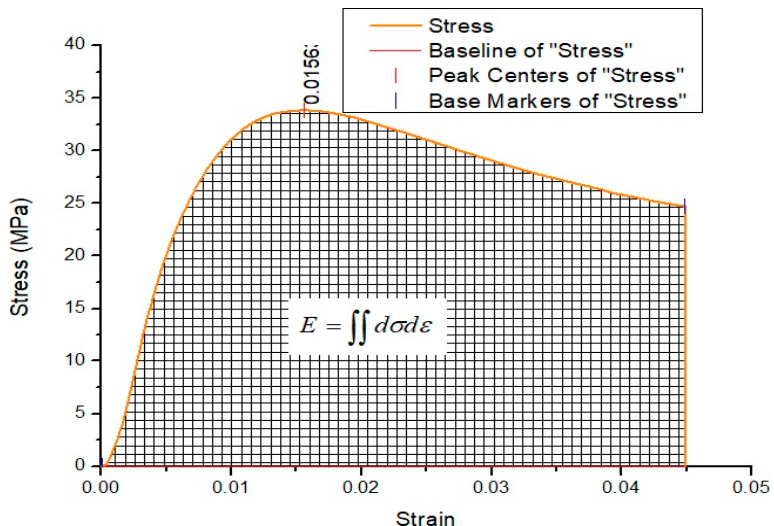
Figure 19. The area under stress-strain curve using OriginPro.